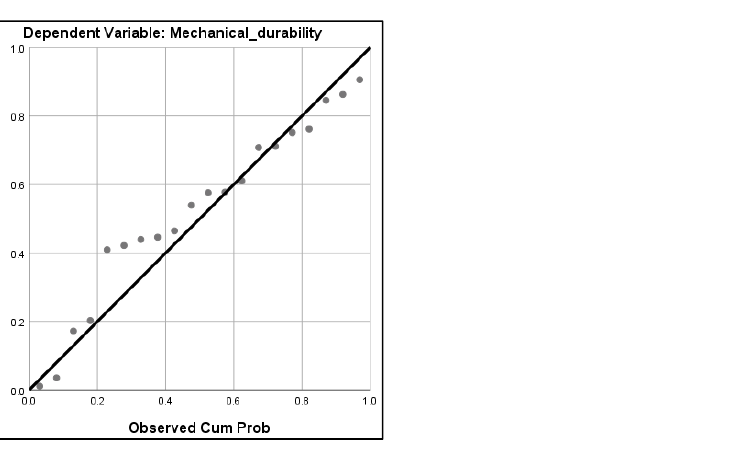
Figure 7. Mean values for the mechanical durability (%) of pellets (the red dashed lines correspond to the quality classes’ threshold values).